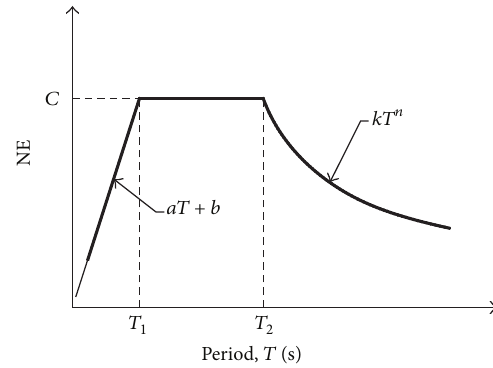
Figure 5: Proposed normalized input energy spectra.